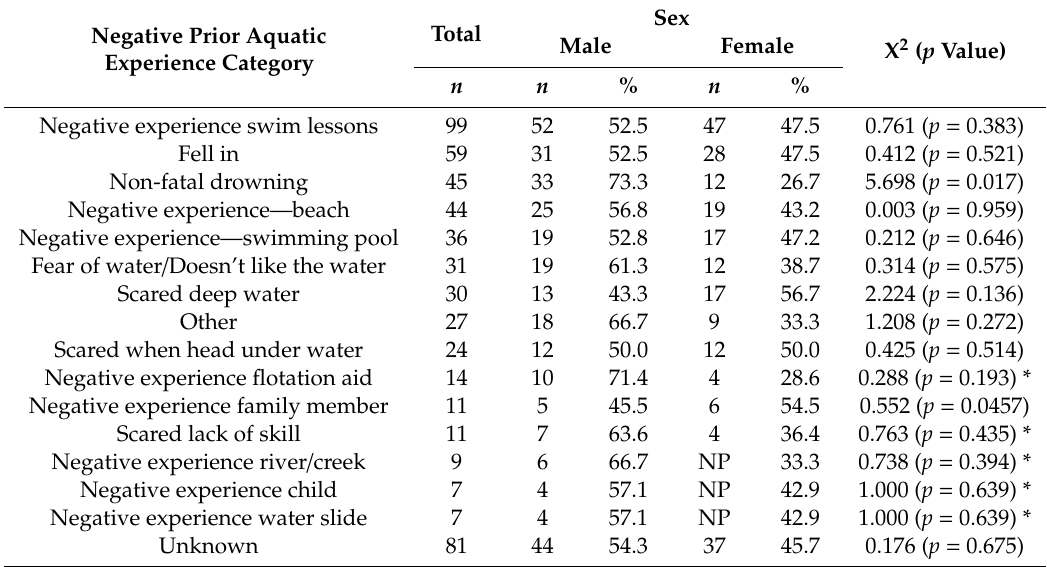
Table 3. Category of negative prior aquatic experience by sex.